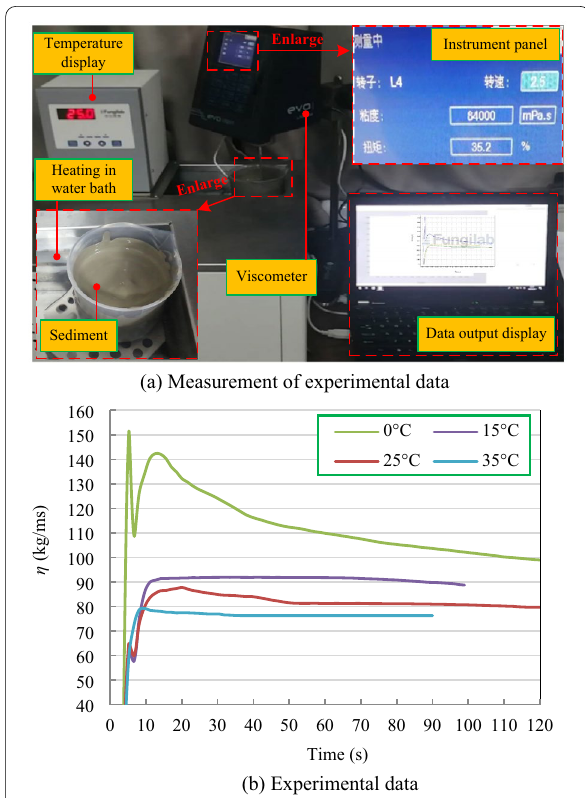
Figure 17 Determination of sediments dynamic viscosity